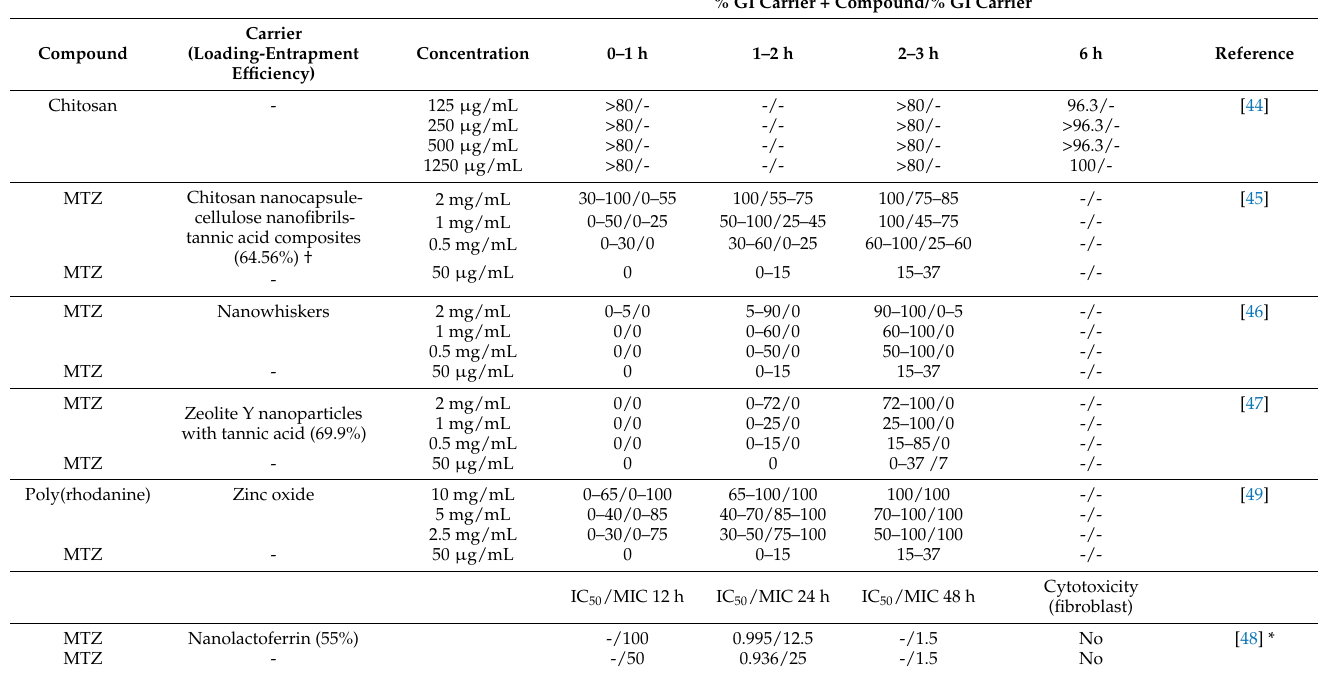
Table 4. Novel treatments against T. gallinae , including novel formulations evaluated employing in vitro experiments. %GI: percentage of growth inhibition. IC 50 ( µ g/mL): concentration needed to produce 50% trophozoite mortality. MIC ( µ g/mL): minimum inhibitory concentration: concentration at which no movement of trophozoites was